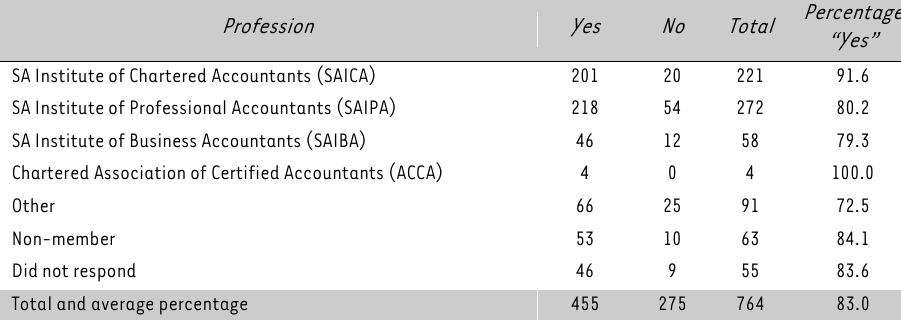
TABLE 6.1: The need for a third tier reporting framework analysed by profession